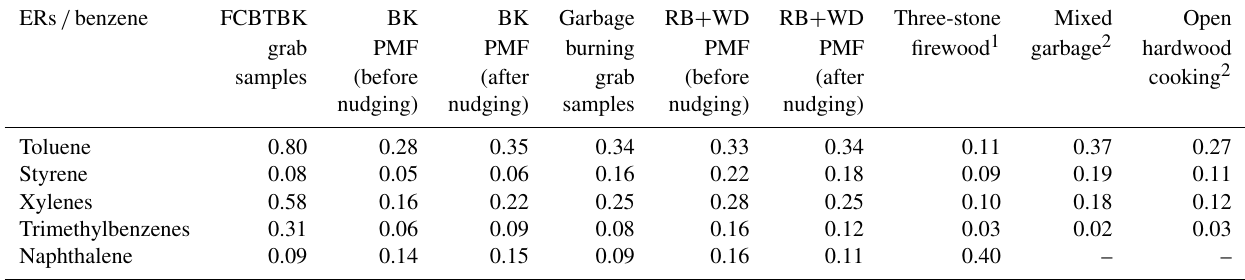
Table 3. Comparison of aromatics / benzene ERs (emission ratios) obtained from PMF (before and after nudging), respective grab samples, the three-stone firewood source reported in Stockwell et al. (2015) and the mixed-garbage-burning and open-cooking-fire sources reported in Stockwell et al. (2016). FCBTBK BK BK Garbage RB + WD RB + WD Three-stone Mixed Open grab PMF PMF burning PMF PMF firewood 1 garbage 2 hardwood samples (before (after grab (before (after cooking 2 nudging) nudging)